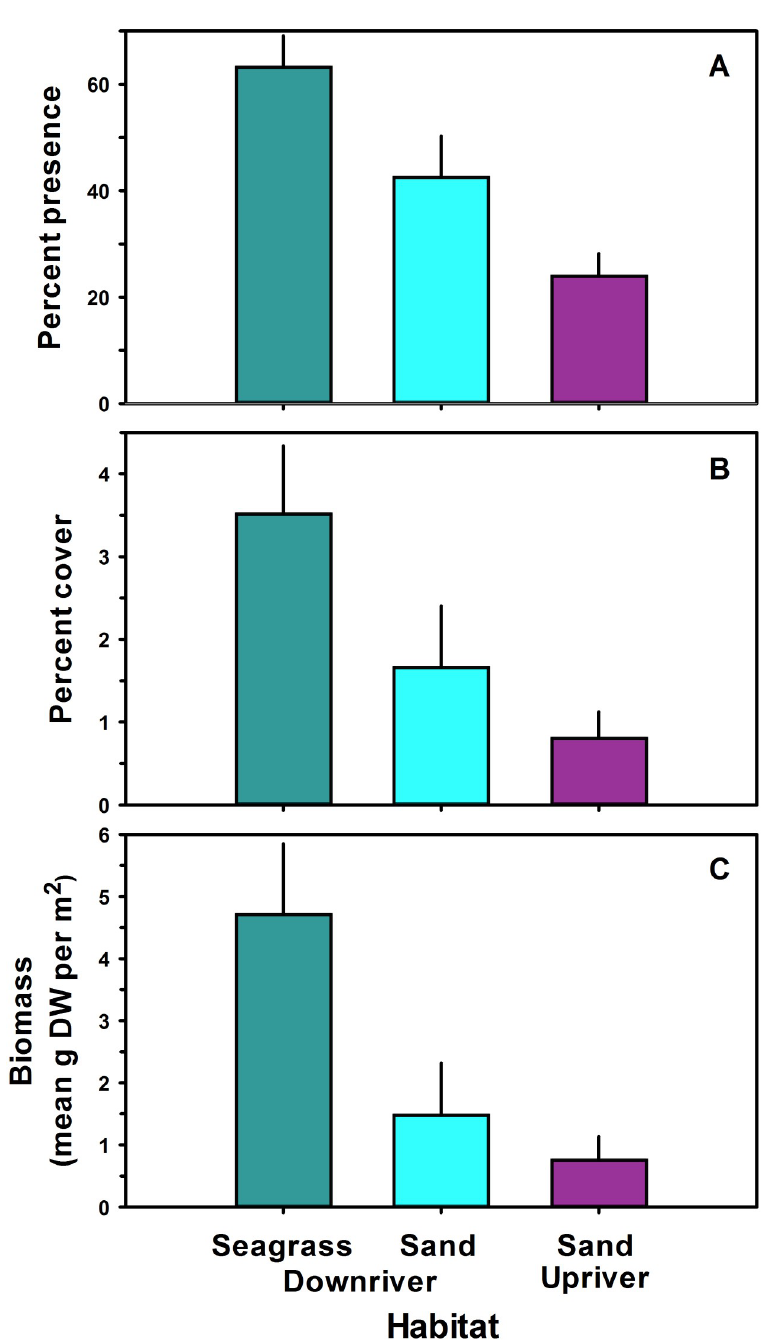
Fig 4. Mean percent presence (A), percent cover (B) and biomass (C) of Gracilaria vermiculophylla in downriver seagrass, downriver sand and midriver sand sites. Vertical bars represent 1 standard error of the